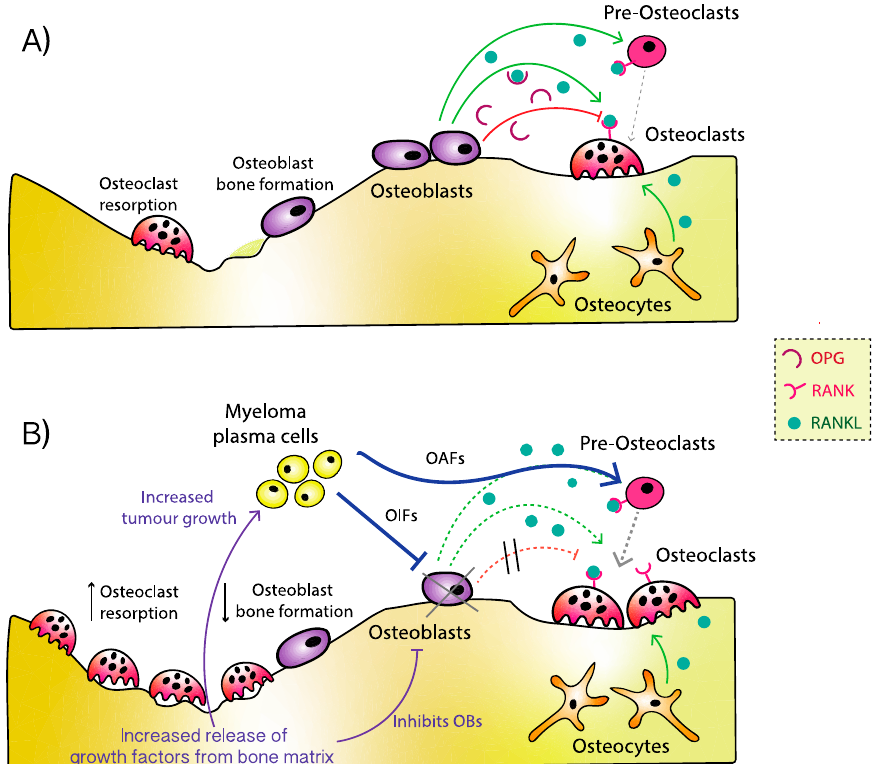
Figure 1. Myeloma bone disease: the vicious cycle: ( A ) in a disease-free state, bone remodelling is a balanced equilibrium of OC-driven bone resorption and OB-driven bone formation, controlled mainly by RANK/RANKL/OPG. OCYs and OBs release RANKL, which binds to RANK on pre-OC and OCs, promoting OC differentiation and activation. OBs also release OPG, which acts as a decoy receptor, and blocks RANKL to oppose osteoclastogenesis. ( B ) In the presence of MPCs, there are both directly and indirectly released OAFs and OIFs, resulting in a promotion of osteoclastogenesis and inhibition of osteogenesis. Bone resorption becomes unopposed, due to reduced OB numbers and depleted OPG. To add to this, in- creased levels of growth factors, such as TGF β and IL-6, are released from the bone matrix, promoting tumour growth, as well as further opposing OB formation and function.